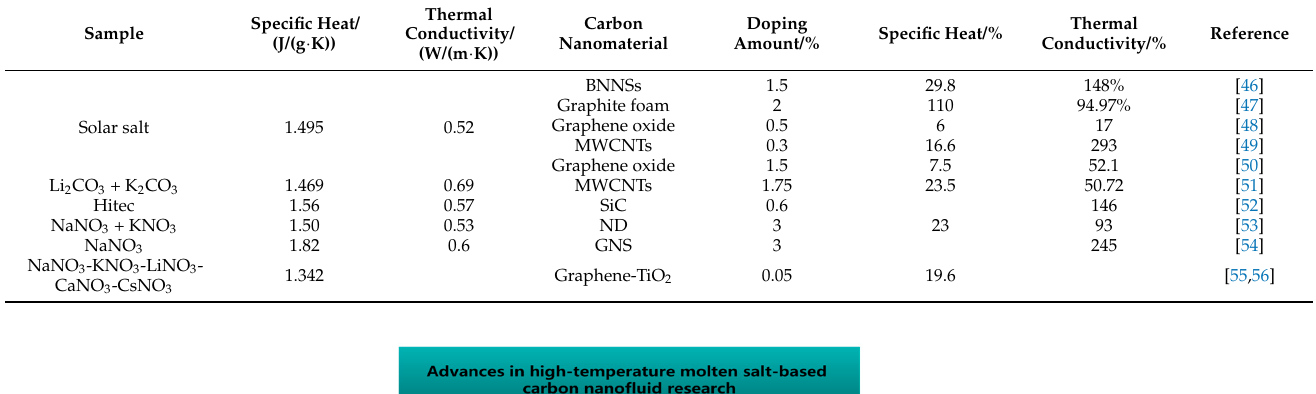
Table 1. Improvement of heat storage and heat transfer properties of nano carbon materials.